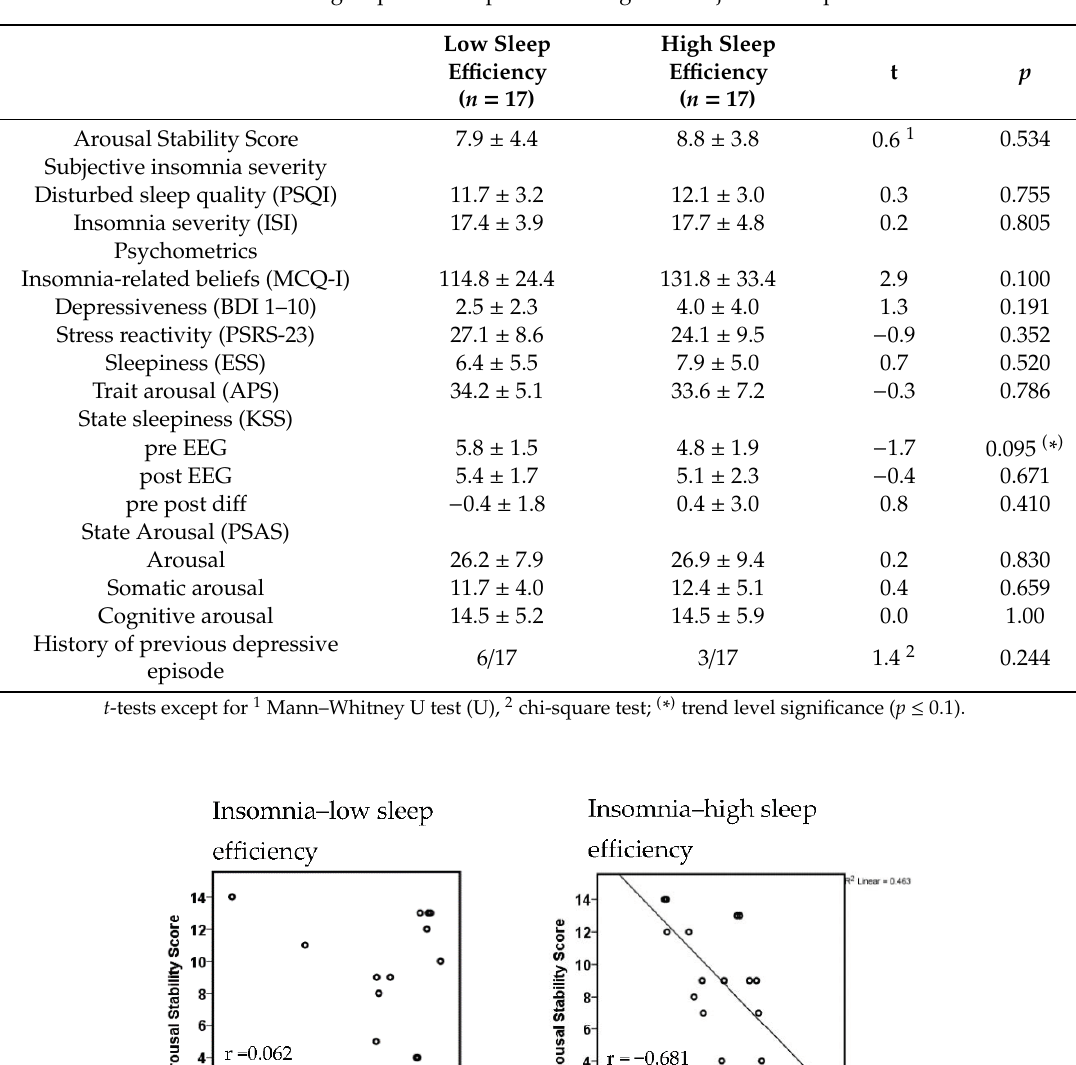
Table 3. Insomnia subgroups with respect to the degree of objective sleep disturbance.